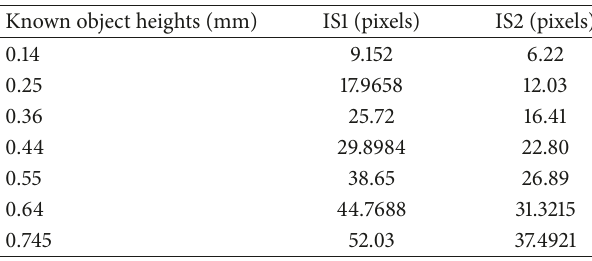
Table 2: Calibration data.